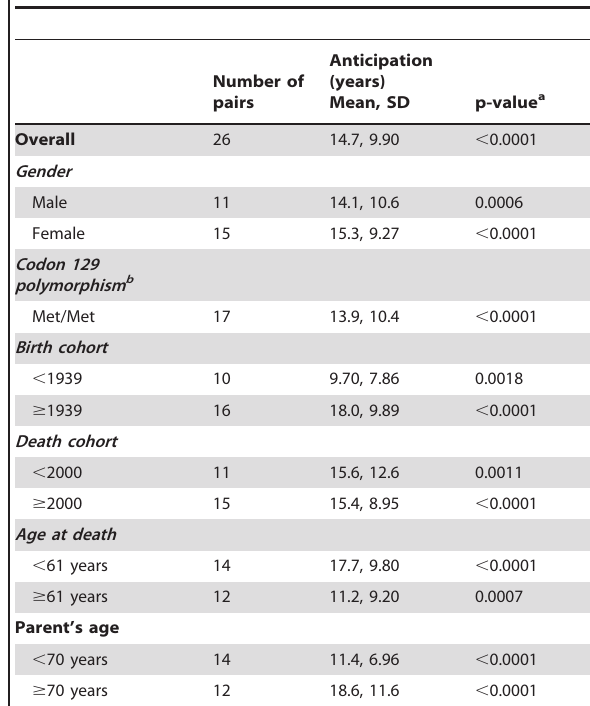
Table 3. Analyses of possible selection biases or confounding factors by offspring